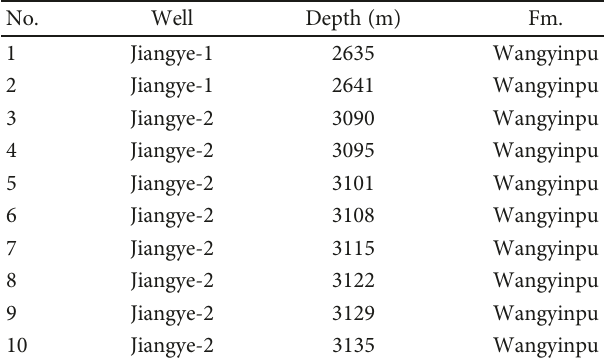
Table 2: Information of samples for permeability tests. See Figure 1 for the well